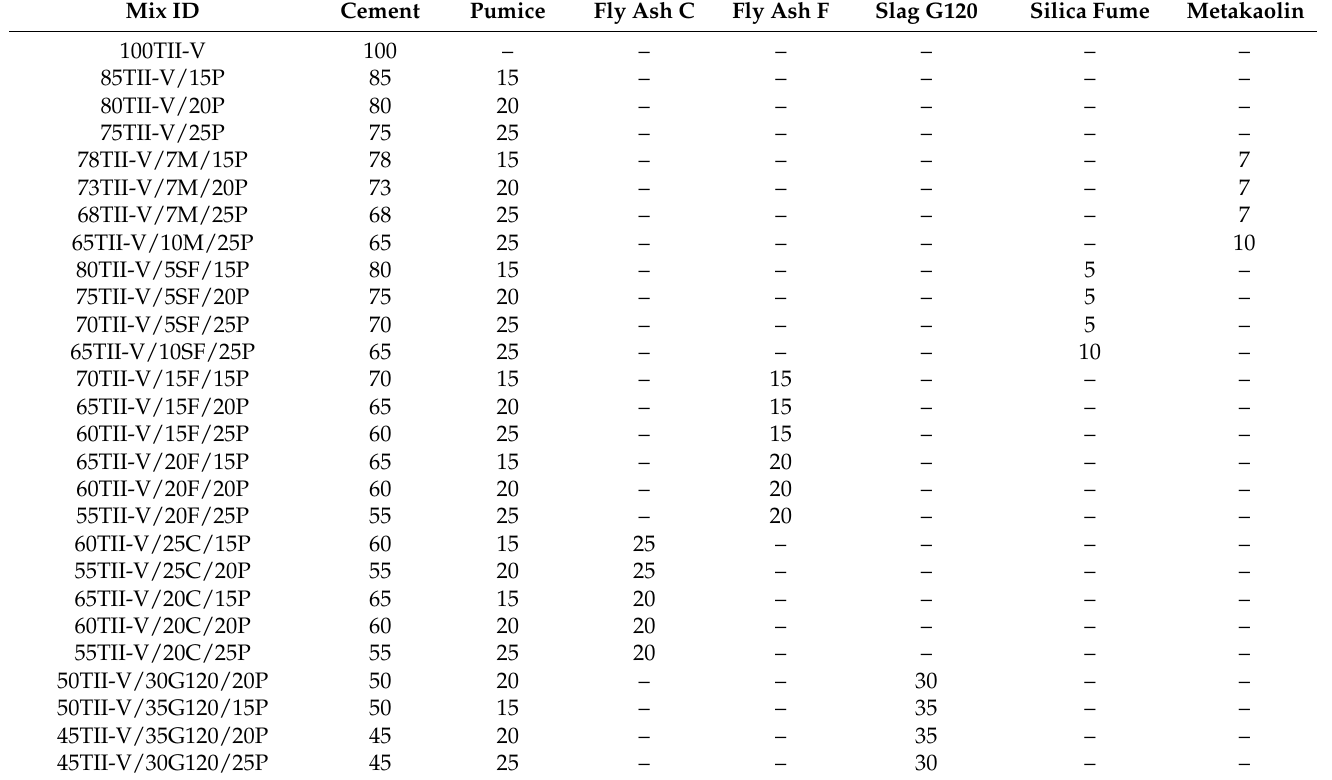
Table 1. Concrete mixtures’ cementitious material constituents and proportions